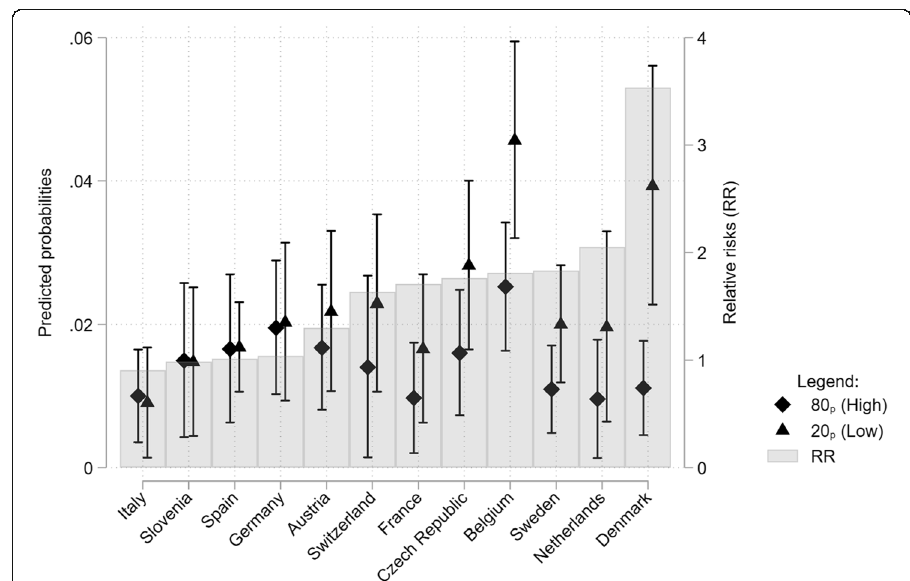
Fig. 6 Predicted probabilities (left axis) and 95% confidence intervals for low educated (triangles) and high educated (diamonds) and associate relative risks (bars; right axis) of being in a nursing home by country, controlling for respondent ’ s sex, age, and health status